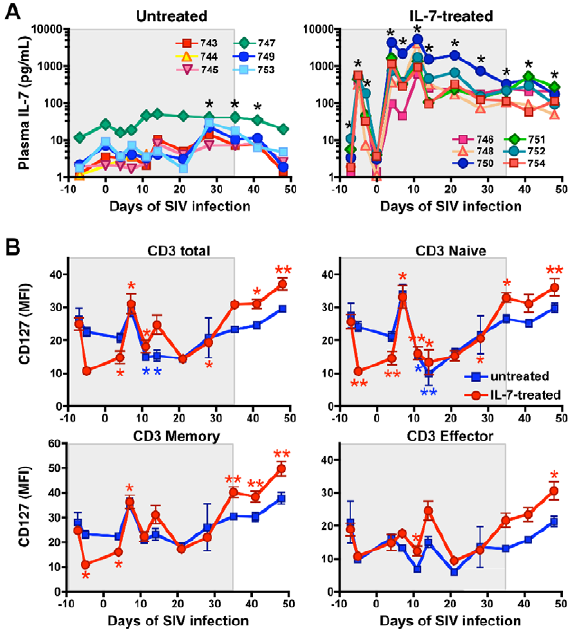
Figure 1. IL-7 pharmacokinetics and CD127 expression in circulating T cells in IL-7-treated and untreated animals. (A) Plasma IL-7 concentrations in IL-7-treated and untreated macaques. IL- 7-treated animals received 7 weekly injections of 50 m g/kg of body weight of a recombinant, fully glycosylated form of simian IL-7 (the grey shaded area indicates the IL-7-treatment period). The asterisks denote significant differences with baseline values (p , 0.05 by paired Student’s t test). (B) CD127 expression on total, naı¨ve, memory and effector CD3 + T cells from untreated (blue) and IL-7-treated (red) animals. Average values of mean fluorescence intensity (MFI) 6 standard error of the mean (SEM) from each group of macaques are shown. Blue and red asterisks denote significant differences with baseline values (day 2 7) in untreated and treated animals, respectively (* p , 0.05, ** p , 0.01, by paired Student’s t